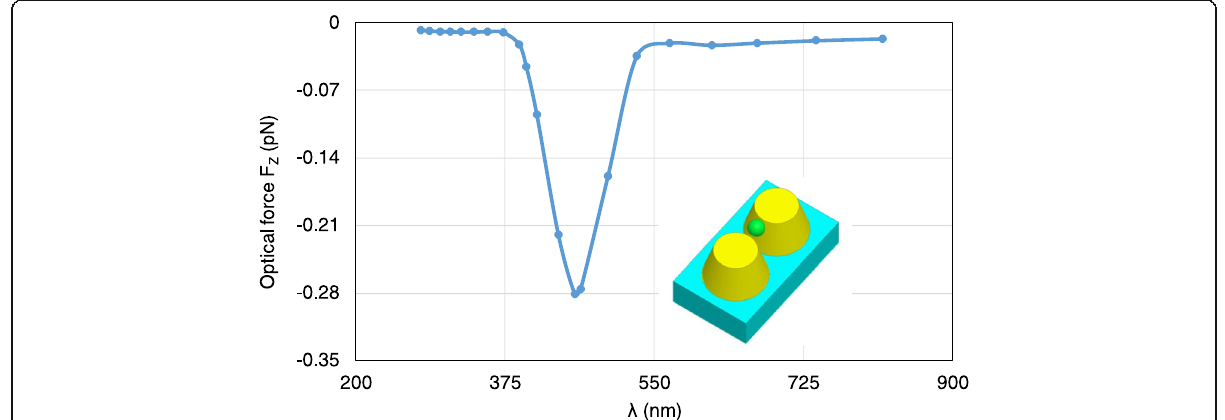
Fig. 10 Calculated results of optical forces exerted on the nanosphere in the system of gold truncated cone dimer, varying with λ . The nanosphere is located at (0, 0, 35 nm)